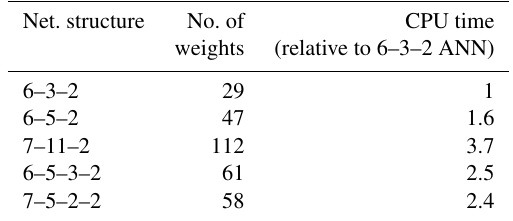
Figure 7. The architecture of the 6–3–2 ANN implemented in the land surface model. Input is described in Sect. 2.6. Purple circles are bias